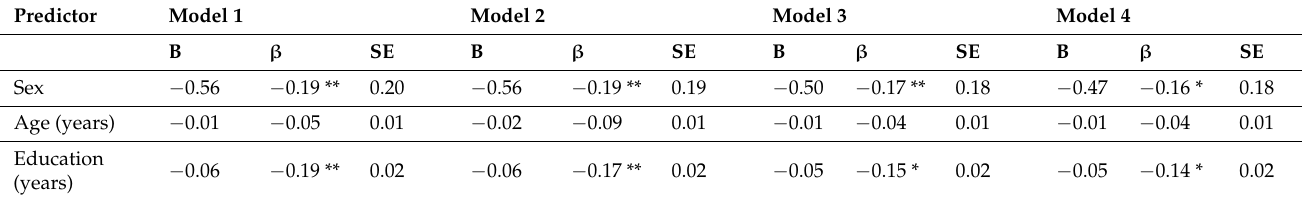
Table 3. Hierarchical regression of attachment and loneliness in